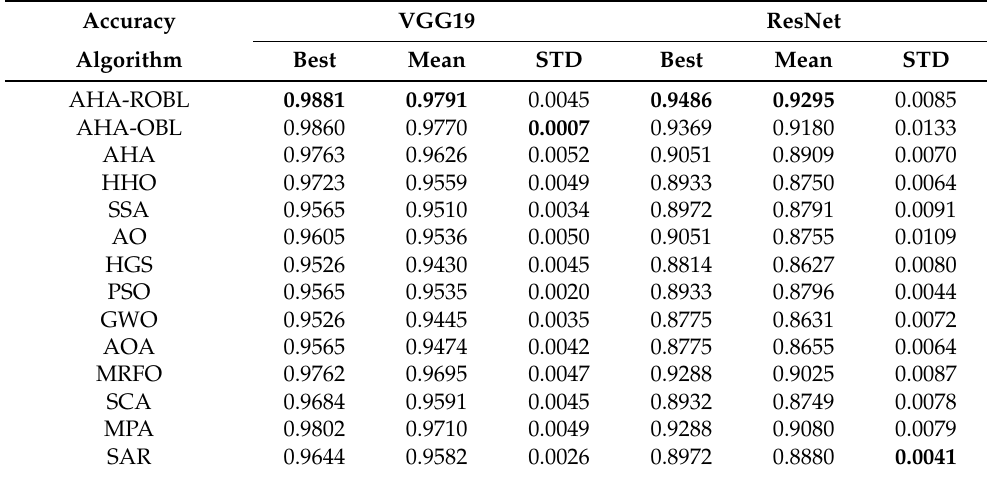
Table 3. Comparison of the performance of deep feature models of the AHA-ROBL with other recent optimizers versus